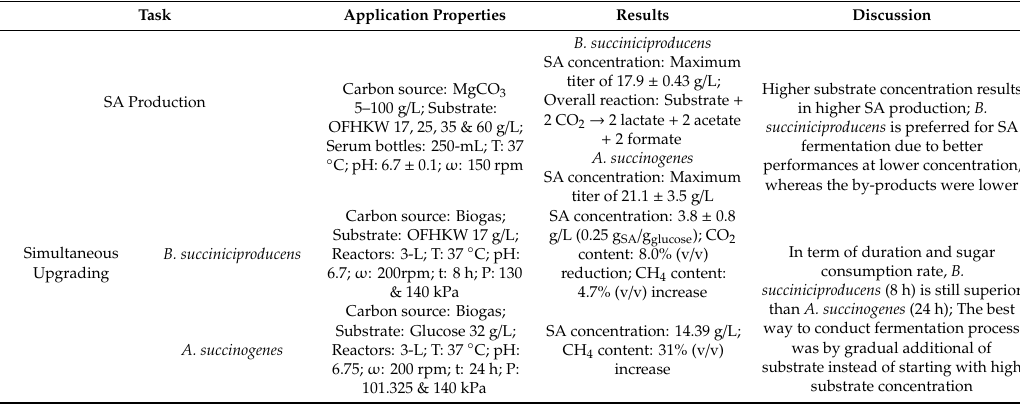
Table 5. Summary of the fermentation process using either B. succiniciproducens or A. succinogenes as bacterial